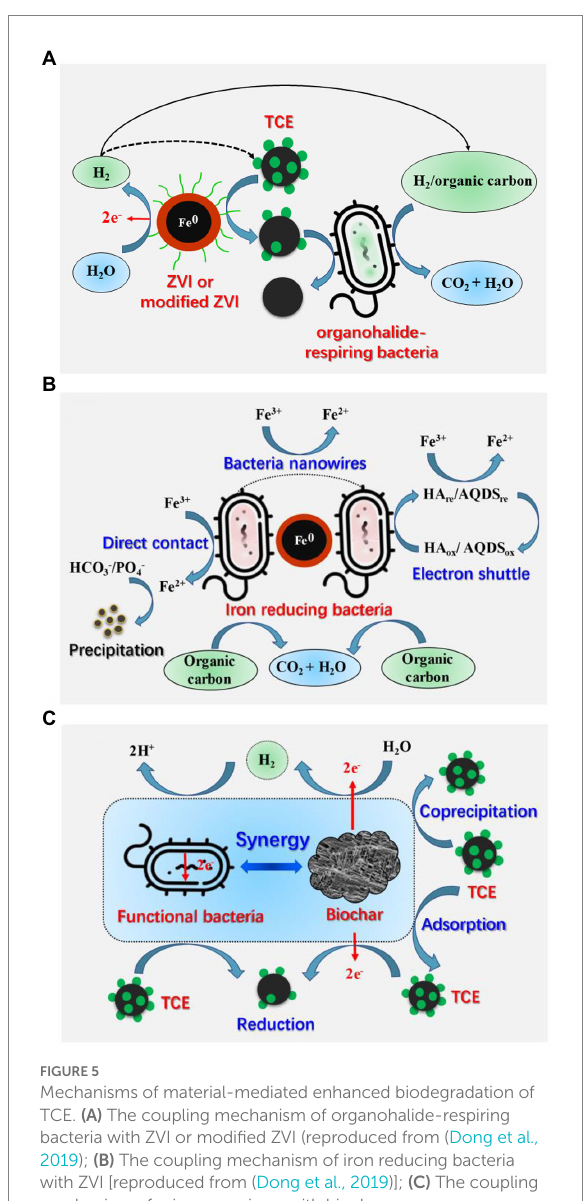
FIGURE 5 Mechanisms of material-mediated enhanced biodegradation of TCE. (A) The coupling mechanism of organohalide-respiring bacteria with ZVI or modified ZVI (reproduced from (Dong et al., 2019); (B) The coupling mechanism of iron reducing bacteria with ZVI [reproduced from (Dong et al., 2019)]; (C) The coupling mechanism of microorganisms with